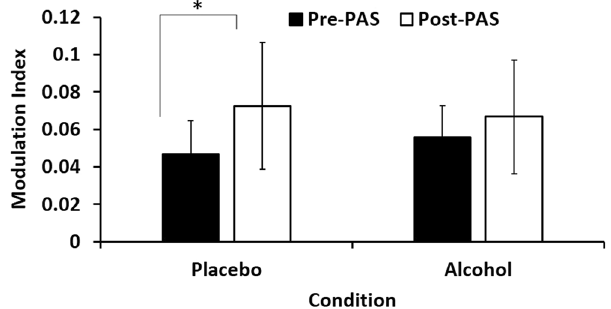
Figure 4. Theta-gamma coupling. Theta-gamma coupling is indexed through the modulation index (MI). There was a significant increase in MI following PAS with placebo beverage. This significant increase in MI was not observed following PAS with the alcohol beverage. Error bars represent the standard